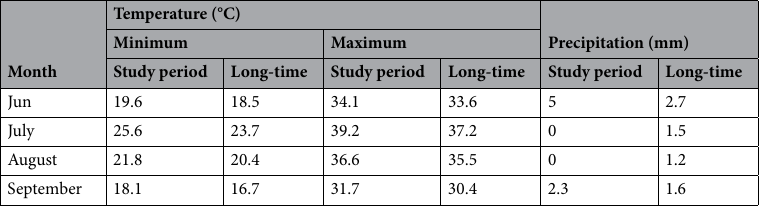
Table 2. Temperature and precipitation data of study area for the growing season and long-time period